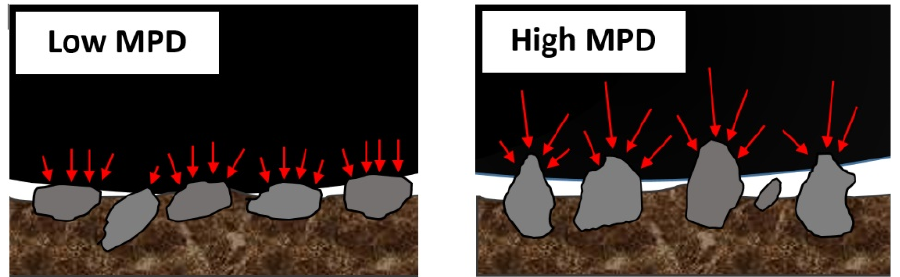
Figure 2. Tire enveloping on two very different road pavements.